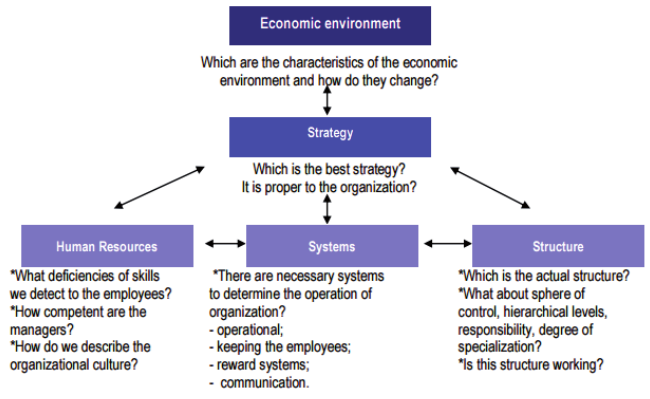
Fig. 1 - How to organize for a change. Source: Clarke (2004, p. 37; In: Bold,